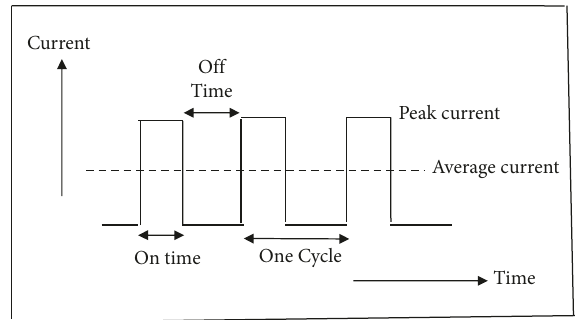
Figure 2: Typical EDM pulse current train for controlled pulse